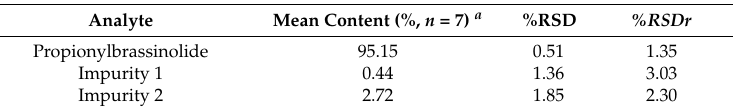
Table 3. Determination of propionylbrassinolide and two impurities in propionylbrassinolide technical concentrate (TC).